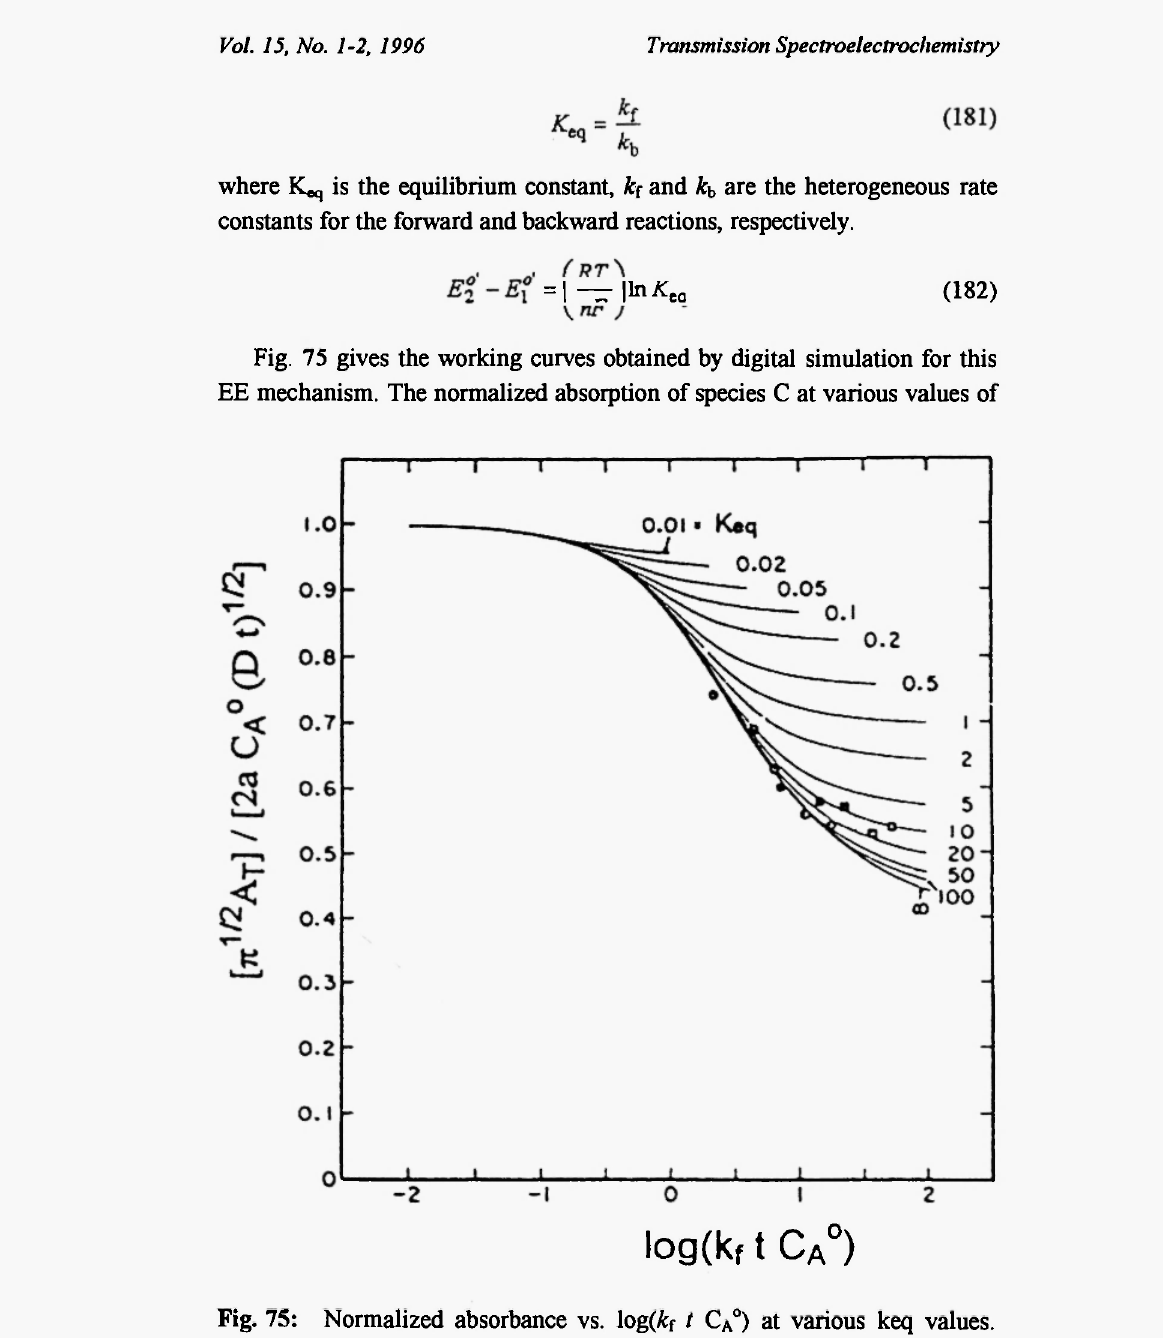
Fig. 75: Normalized absorbance vs. log(& f t C A °) at various keq values. Circles are for 6.0 χ ΙΟ" 4 Μ o-tolidine. Squares are for 2.0 χ 10" 3 Mo-tolidine (From Ref.